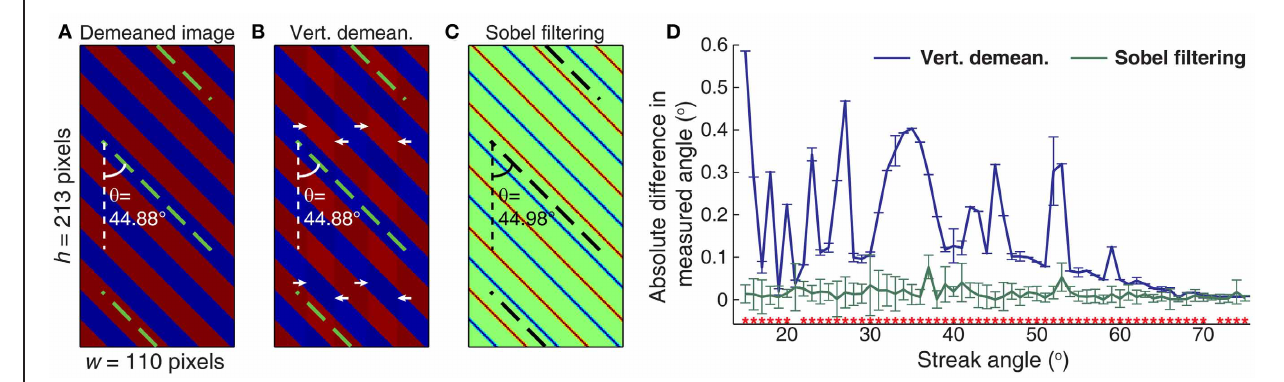
44.98 ◦ (dashed black lines) on the Radon transform, an error of 0.02 ◦ . Thirteen iterations of the Radon transforms (52 Radon transforms) resulted in an angle step-size of ∼ 0.002 ◦ (see Equation 19). (D) Sobel filtered images offer more accurate angle measurements when compared with vertically demeaned images. Mean ± SD of absolute difference in measured angles on simulated images are shown. Each angle value consists of results from n = 36 images withstreaks atdifferent spatial locations. Statistically significant differences are represented by a red asterisk for a given angle ( p < 0 . 05, two-sample t